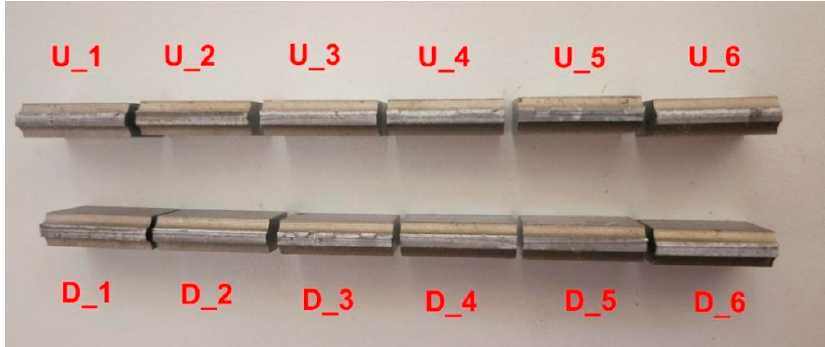
Figure 7. Macroscopic fracture morphology of all specimens.